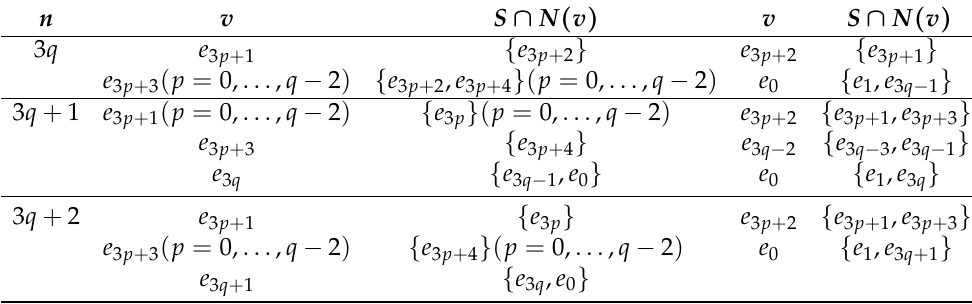
Table 1. Open locating-dominating vertices in C n .